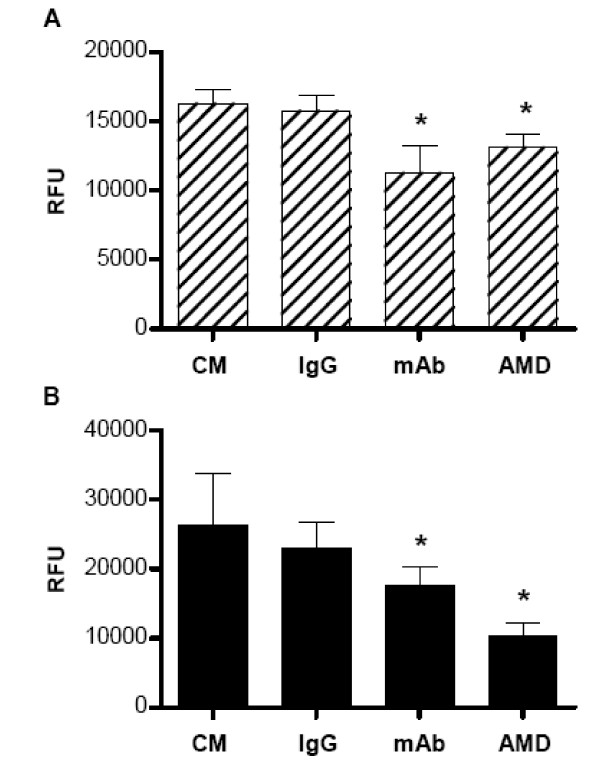
The effect of CXCR4 inhibition on cell migration (A) and invasion (B) in hypoxia-treated breast cancer cells. Human breast cancer cell line, MCF7 cells were exposed to hypoxia (2% O2 with 5% CO2) for 48 hrs, and further incubated with either a CXCR4 blocking mAb, MAB172 (mAB, 10 μg/ml), or a CXCR4 antagonist, AMD3100 (AMD, 100 nM) for 1 hr. Culture medium (CM) and control IgG2b mAb, MAB004 (IgG, 10 μg/ml) were used as the control. Cell migration and invasion were assessed as described in the Methods and expressed as (relative fluorescence units RFU). Data are presented as the mean ± SD of duplicate samples and are representative of three independent experiments. *p < 0.05 versus CM or IgG treated cells.